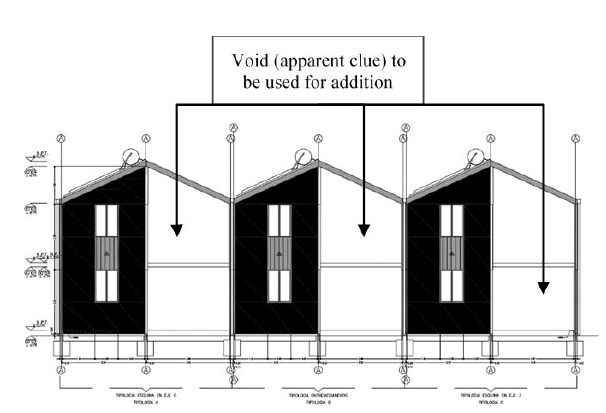
Fig. 7. Insight from Aravena’s Design Source: ELEMEN- TAL